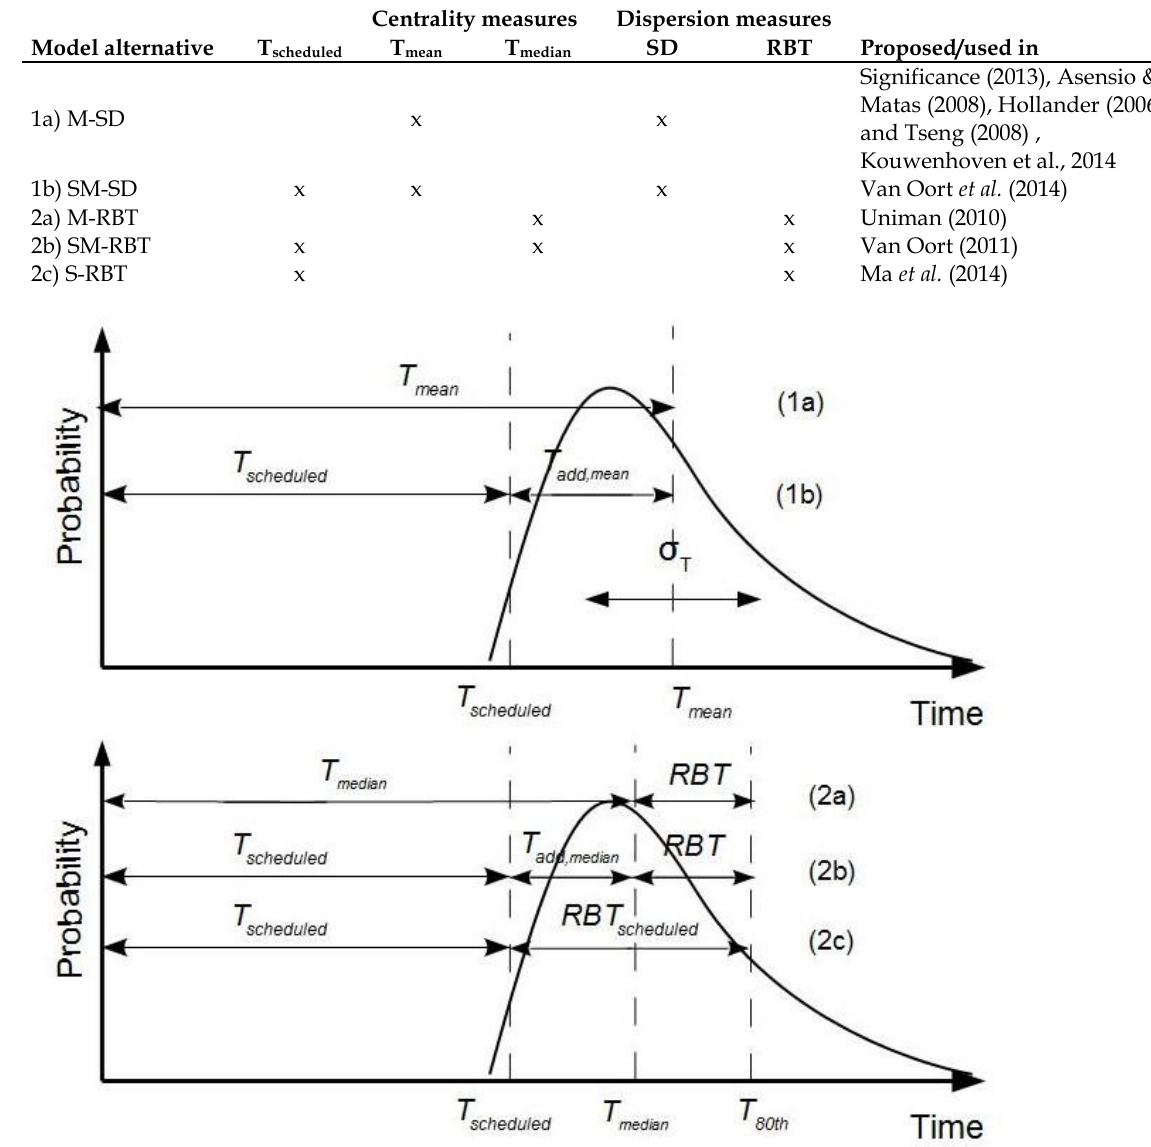
Figure 1. Illustration of SD- and